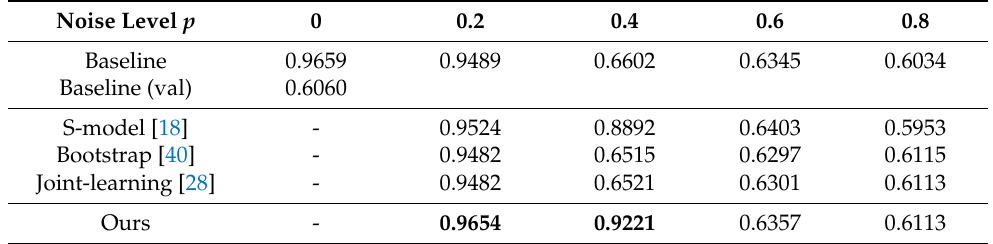
Table 1. Comparison of test performance with various methods for handling noisy labels in referable DR classification task. The final AUROC is shown. Bold digits are best results with margins greater than 1%p.